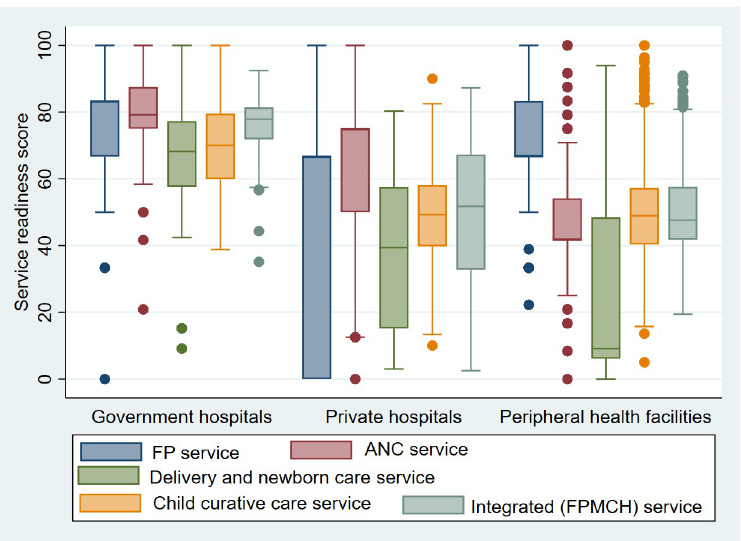
Fig 2. Service readiness score for specific and integrated FPMCH services according to the type of